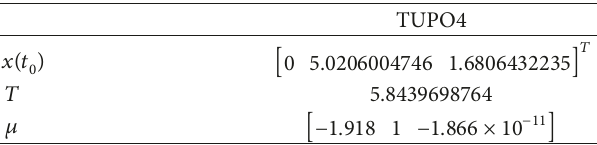
Table2:Poincar´emappoint 𝑥(𝑡 0 ) ,period 𝑇 ,andFloquetmultipliers 𝜇 of a periodic orbit (TUPO4) of the R¨ossler